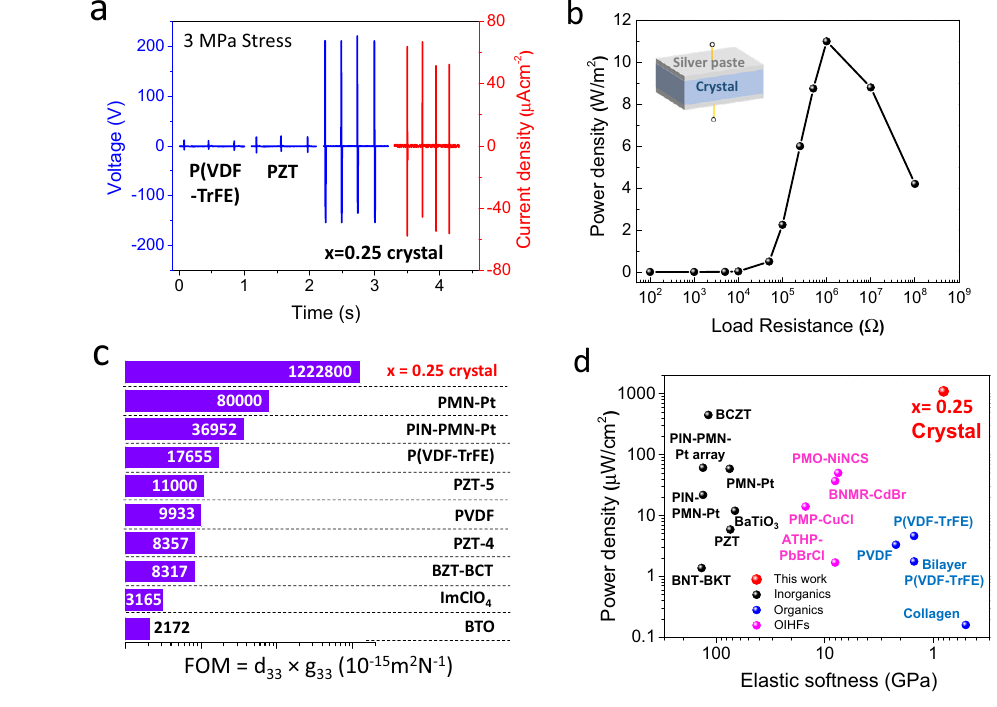
Fig.6|PiezoelectricharvestingpropertiesofSinglecrystalwafer.a Voltageand currentoutputscomparedwithmeasuredPZTandP(VDF-TrFE)samplewithsimilar dimension (5*5*2mm) and applied stress. b Power density under various impe- dance loading of x =0.25 crystal. c Comparison of piezoelectric energy harvester